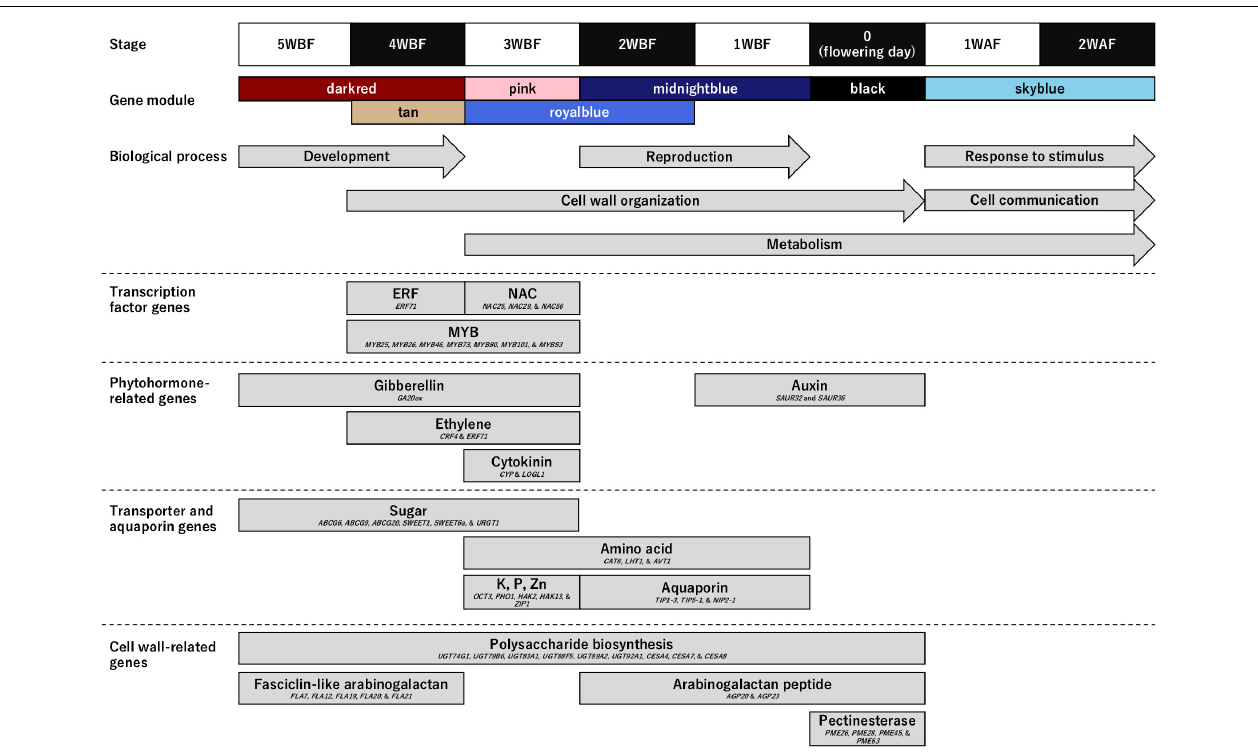
FIGURE 3 | Genes enriched in the biological process (BP) category and involved in the flower opening mechanism in ‘Somei-Yoshino.’ Upper panels show the time frame [from 5 weeks before flowering (WBF) to 2 weeks after flowering (WAF)] and the corresponding gene modules. Arrows indicate the Gene Ontology (GO) terms enriched in the BP category (see Table 1 ). Boxes indicate the properties of the genes highly expressed in the seven characterized modules (see Supplementary Table 3